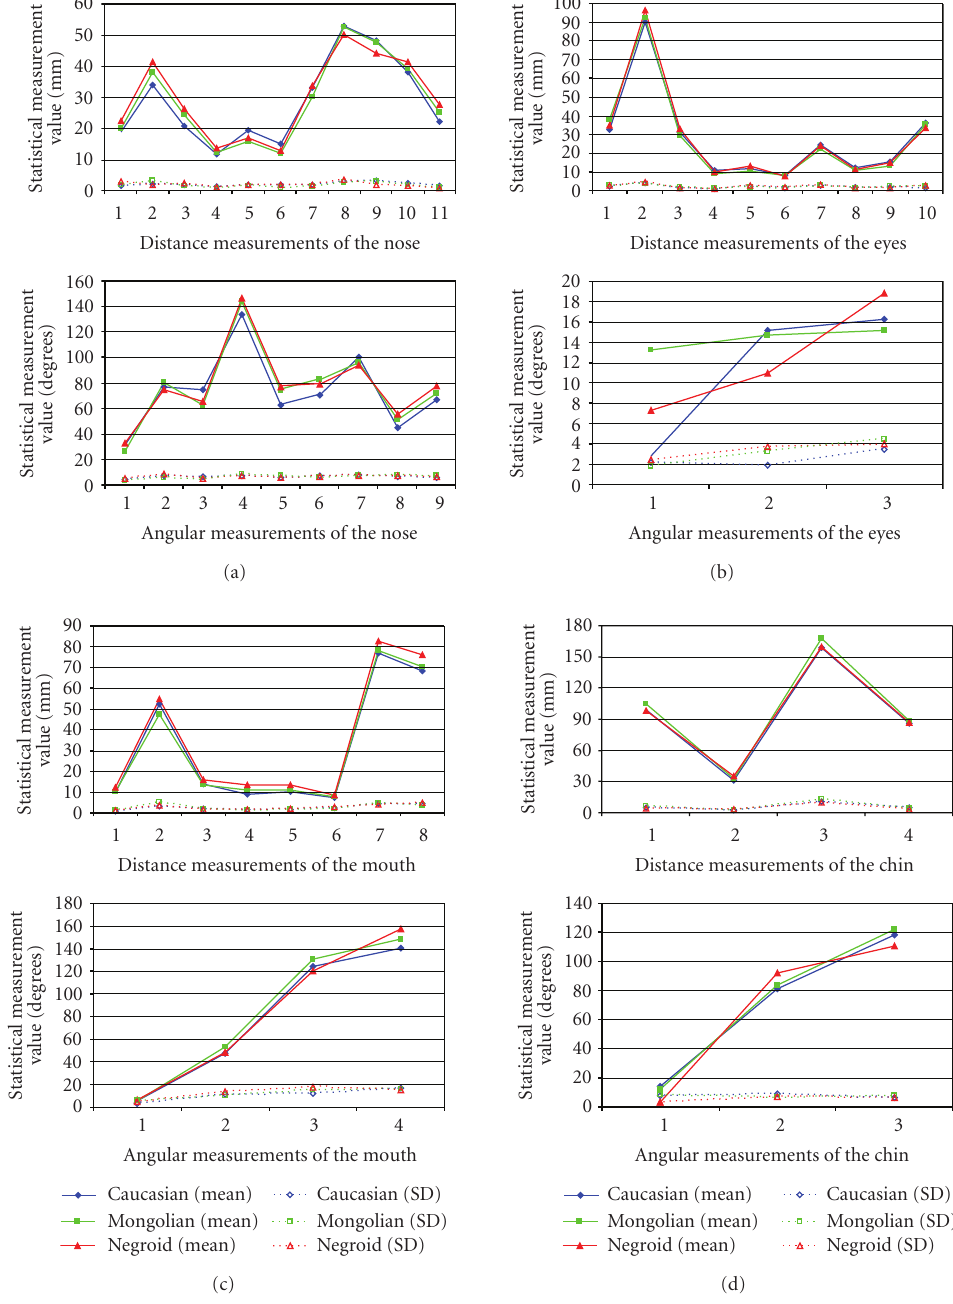
Figure 13: Comparison of statistics of facial feature measurements between races (blue, green and red for groups of Caucasian, Mongolian and Negroid, resp.). Each facial feature: statistics of the distance measurements (top) and statistics of the angular measurements (bottom).